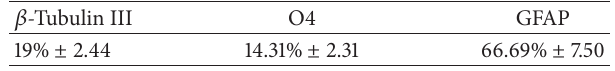
Table 2: The percentage of 𝛽 -tubulin, O4, and